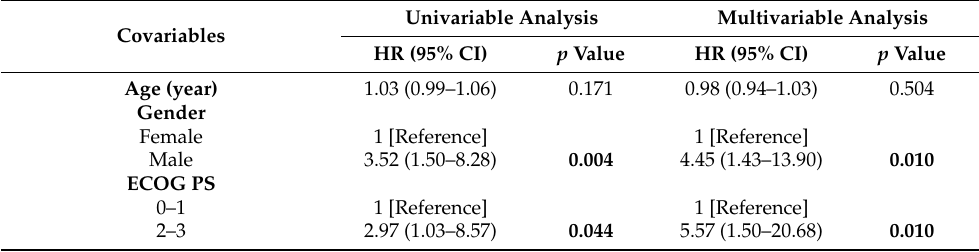
Table 2. Cox proportional hazards regression for